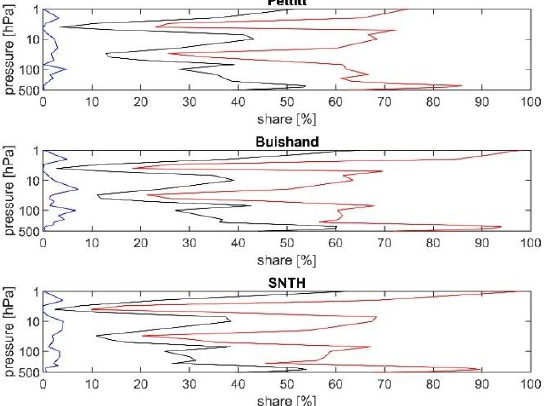
Figure 3. Vertical profile of average (black), minimal (blue) and maximal (red) share of explained discontinuities by the change in 2004 to all discontinuities from all months in the period 1980–2017 from MERRA-2 for the Pettitt test ( upper panel ), the Buishand test ( middle panel ) and the Standard Normal Homogeneity test (SNTH, lower panel ).